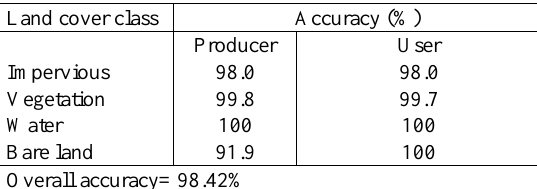
Table 4. Producer and user accuracy (Landsat 5 TM)